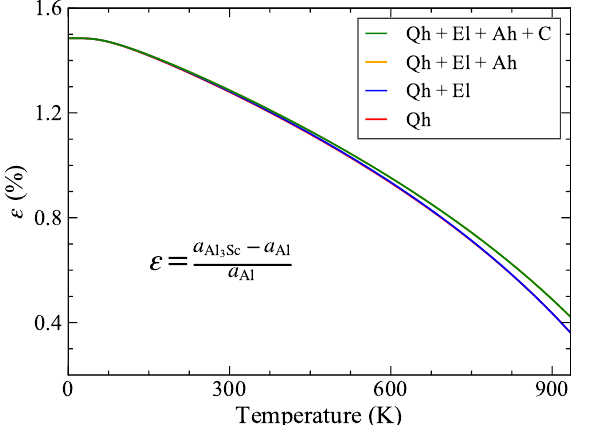
Figure 6. Variation of Al/Al 3 Sc lattice misfit with temperature computed using the stated equation. The quasiharmonic (Qh), electronic (El) and anharmonic (Ah) and electron-phonon coupling (C) contributions are taken into account in the DFT calculations. The red (orange) lines are hidden by the blue (green) lines. The figure has been taken from